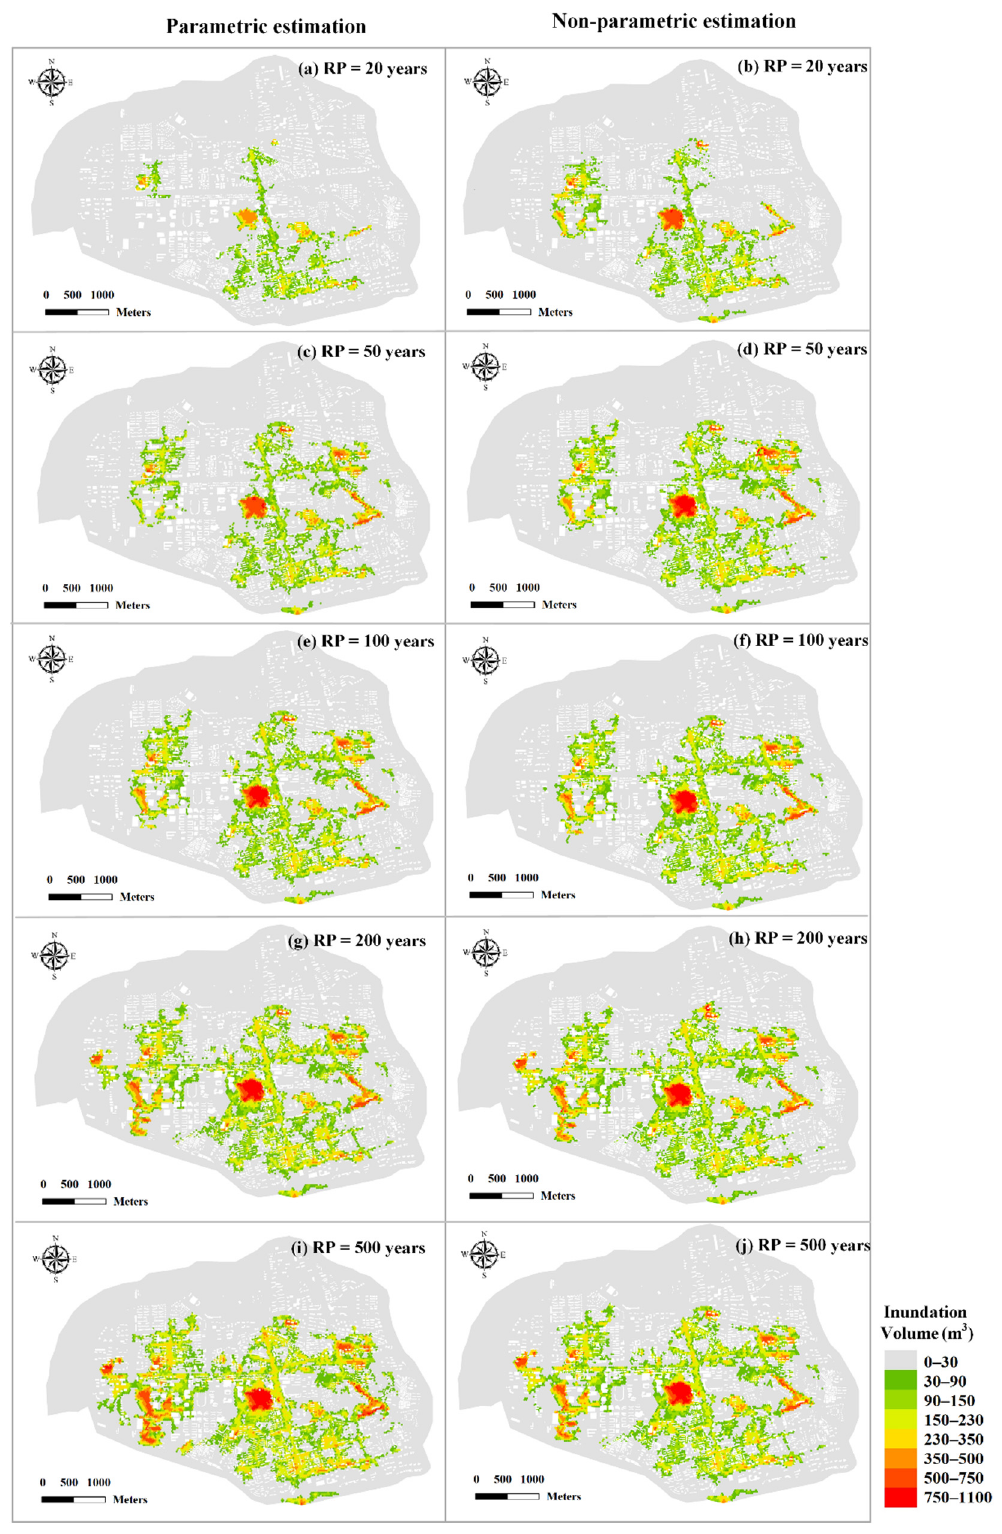
Figure 11. Flooding maps in different RPs for parametric and non-parametric estimation.